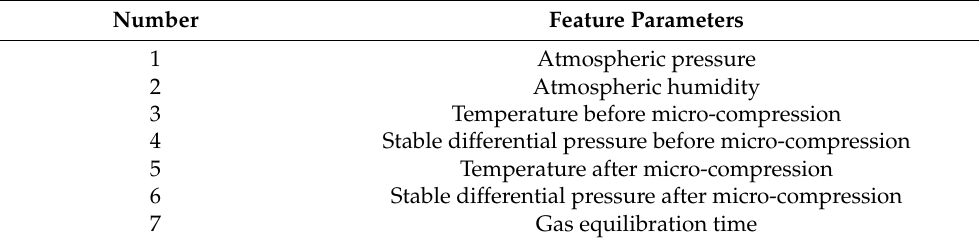
Table 2. Input characteristic parameters of irregular cavity